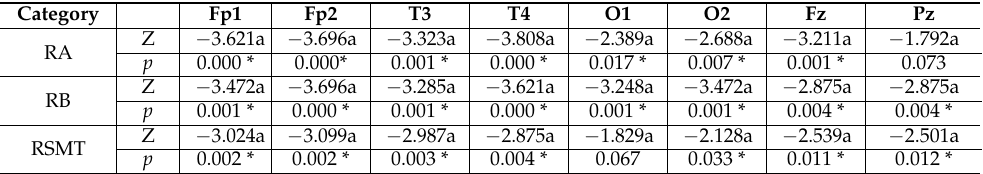
Table 5. VR group post-test EEG